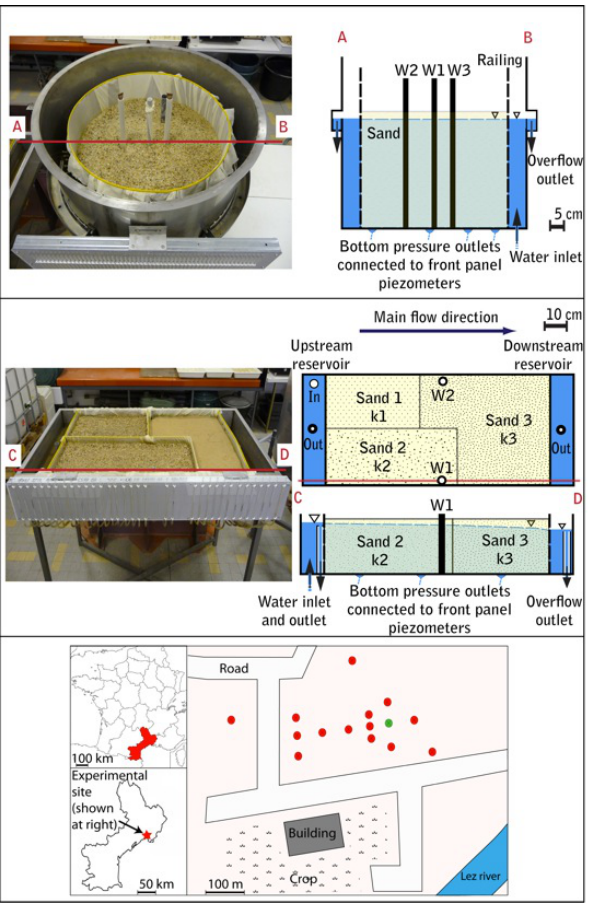
Fig. 3. Photographs and schematics of the circular (top) and rect- angular (middle) tanks, schematic plan of the experimental well test site (bottom). Circular tank schematic (top right): cross sec- tion along the AB profile, W1, W2 and W3 stand for the wells. Rectangular tank schematics (middle right): plan view and cross section along the DC profile, k1, k2 and k3 (here k1 > k2 > k3) are the respective hydraulic conductivities of sand areas 1, 2 and 3, W1 and W2 are wells. Experimental well test site (bottom): the red dots stand for the piezometers, the green dot stands for the pumping